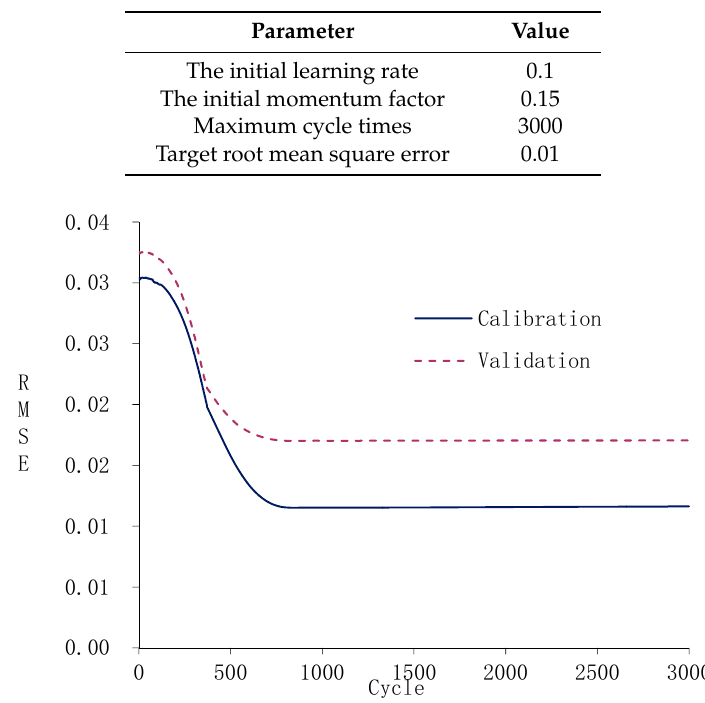
Figure 4. Global error variation of neural network cross validation process.